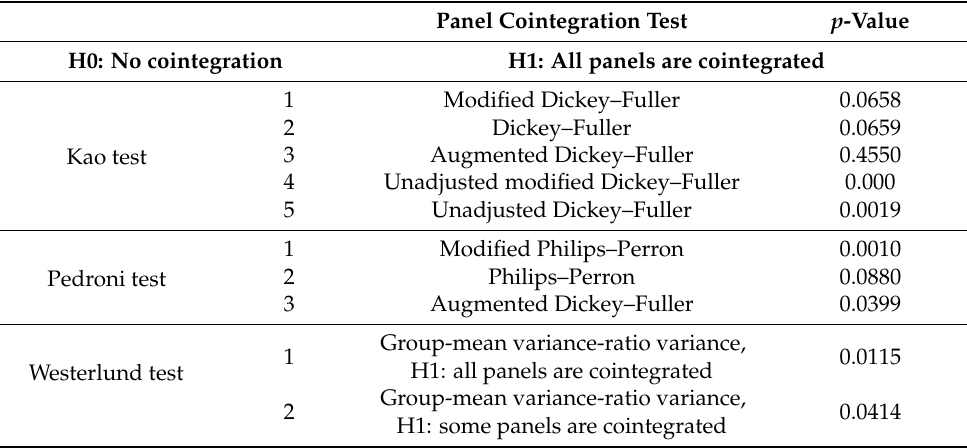
Table 3. Panel cointegration tests; H0: no cointegration; default H1: all panels are cointegrated. Panel Cointegration Test p